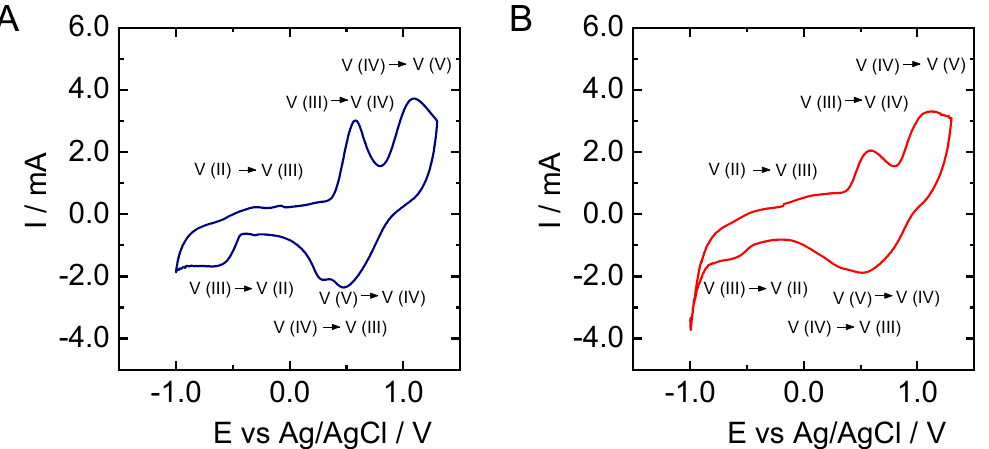
Figure 5. Cyclic voltammograms recorded at 5 mV · s − 1 in 3 M H 2 SO 4 and 0.15 M V(III)/V(IV) solution for carbon nanofibers (CNFs) derived from ( A ) PL; ( B ) KL. Both were pretreated in air and electrospun at 9 kV.